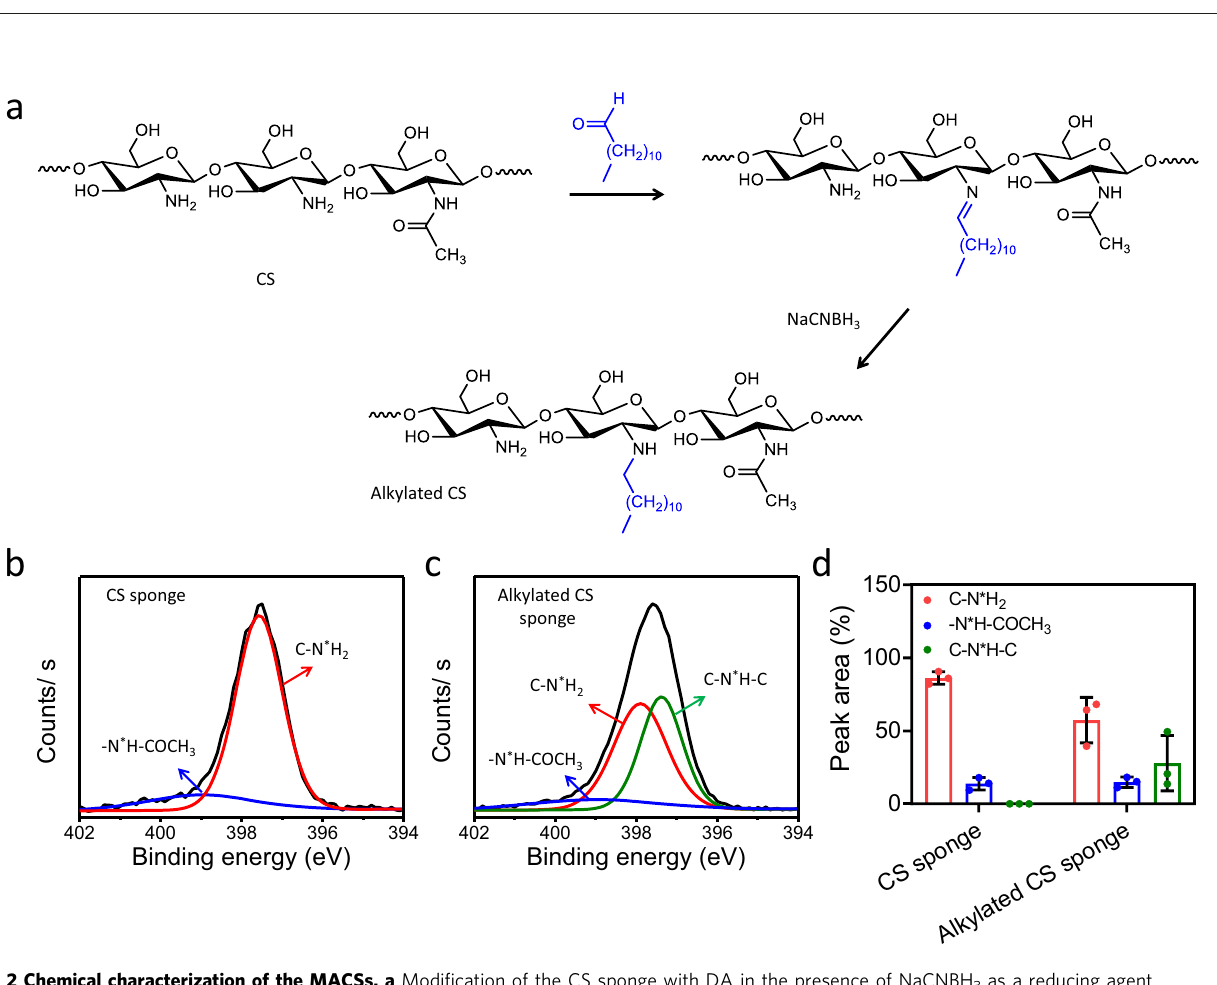
Fig. 1 Fabrication and characterization of the MACSs with different porosity. a Schematic illustration of the fabrication process of the MACSs. b Stereomicroscopic images of the PLA micro fi ber template, CS/PLA composite, micro channeled CS sponge, and micro channeled alkylated CS sponge. c , d Micro-CT and SEM images showing the macro and microstructure of the ACS and MACS-1/2/3. e The pore size of the ACS and MACS-1/2/3 in cross- section and longitudinal-section (pore size, n = 16). f The pore size of the ACS and MACS-1/2/3 in longitudinal-section (pore size, n = 16). g The porosity of the ACS and MACS-1/2/3 (porosity, n = 25). h , i Compressive stress-strain curves and compressive stress of the MACSs with different CS